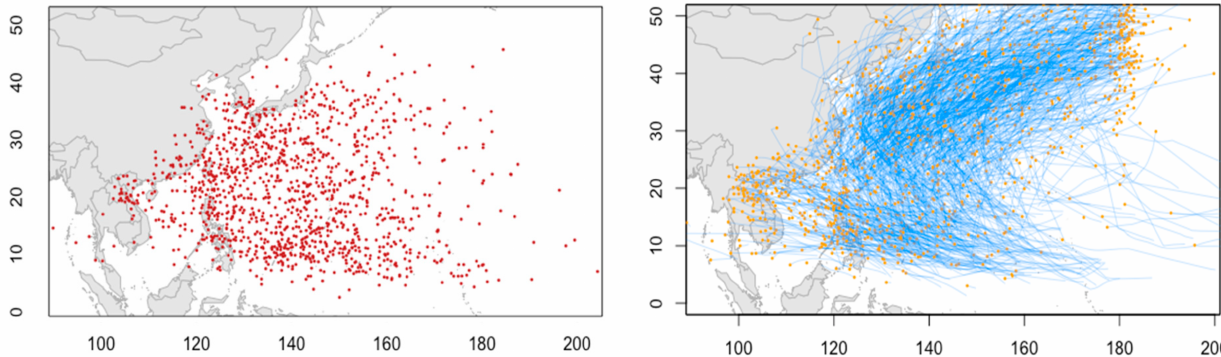
Figure 1. Annual distribution of WNP region observed typhoon genesis locations, tracks and landfall over the 50-year period of 1972 to 2021. Red dots, blue lines and orange dots indicate genesis points, tracks and landfall locations.